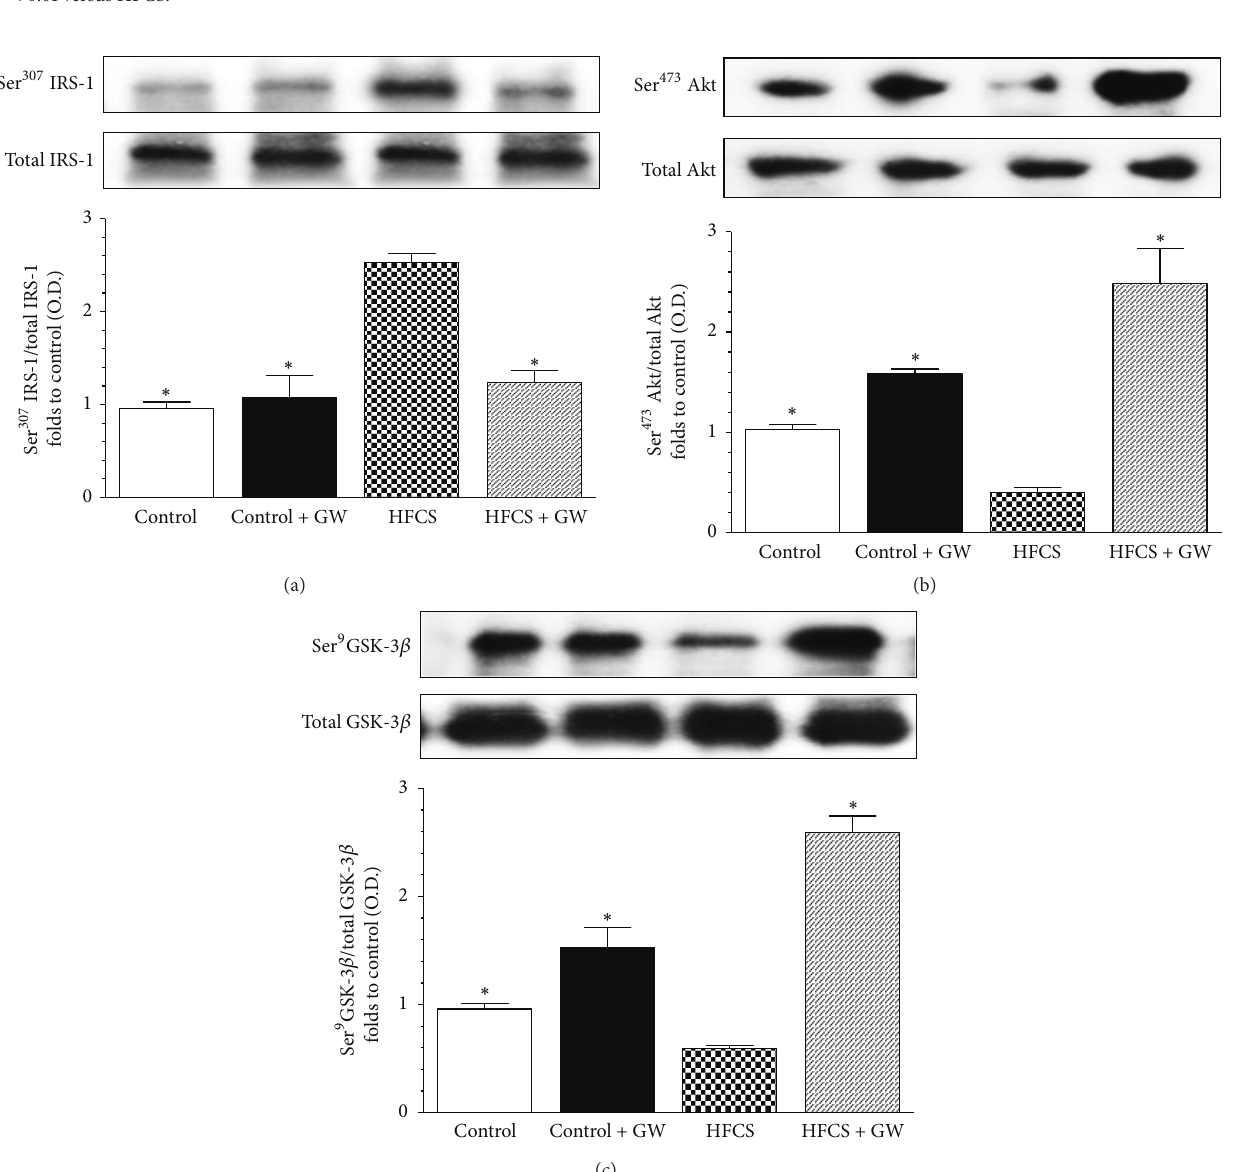
Figure 2: Effects of GW0742 treatment on insulin signal transduction in the gastrocnemius of mice fed with HFCS diet. Total IRS-1 protein expression and Ser 307 phosphorylation (a), total Akt protein expression and Ser 473 phosphorylation (b), and total GSK-3 𝛽 protein expression and Ser 9 phosphorylation (c) were analyzed by western blot on the gastrocnemius homogenates obtained from mice fed with a standard (control) or HFCS diet (HFCS) for 30 weeks and treated with GW0742 (1mg/kg/day) added during the last 16 weeks (control + GW; HFCS + GW). Densitometric analysis of the bands is expressed as relative optical density (O.D.), corrected for the corresponding tubulin contents, and normalized using the related control band. The data are means ± SD of three separate experiments. ∗ 𝑃 < 0.01 versus